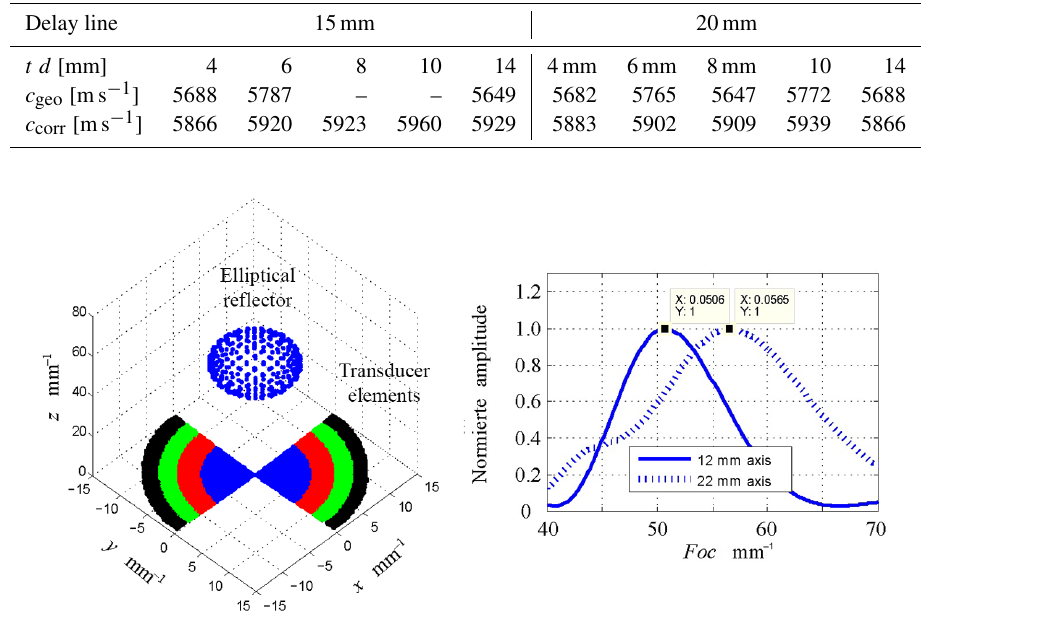
Figure 10. Focused sound emission with two opposite 90 ◦ transducer segments each being divided in radial direction into four elements (left figure). The focusing curves allow the determination of the half-axes of the reflector (right figure).